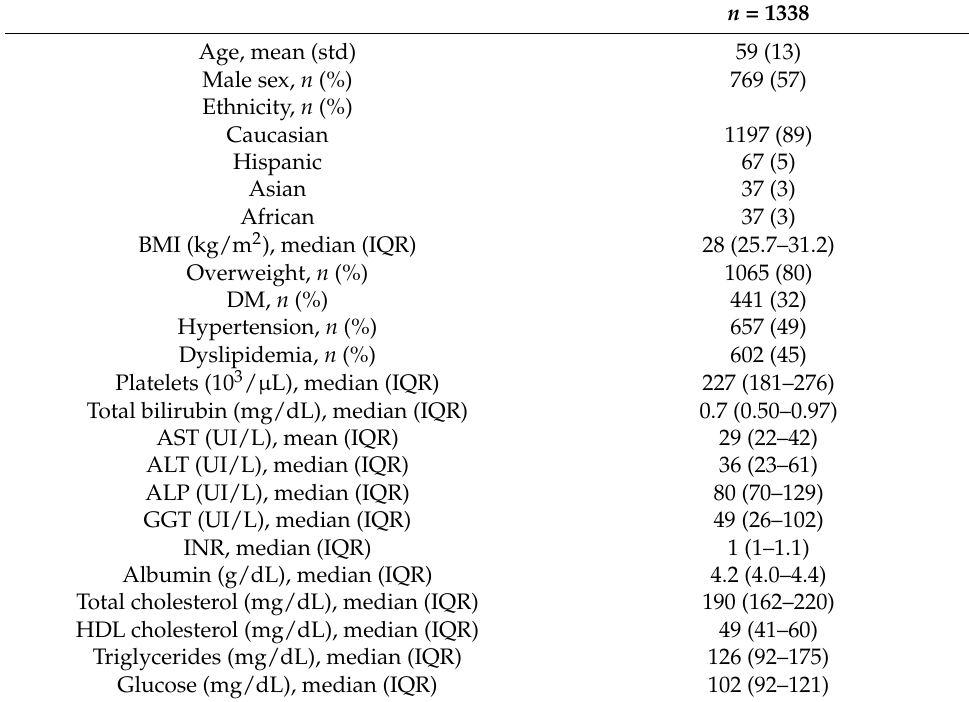
Table 1. Demographic and clinical features of the overall cohort ( n =